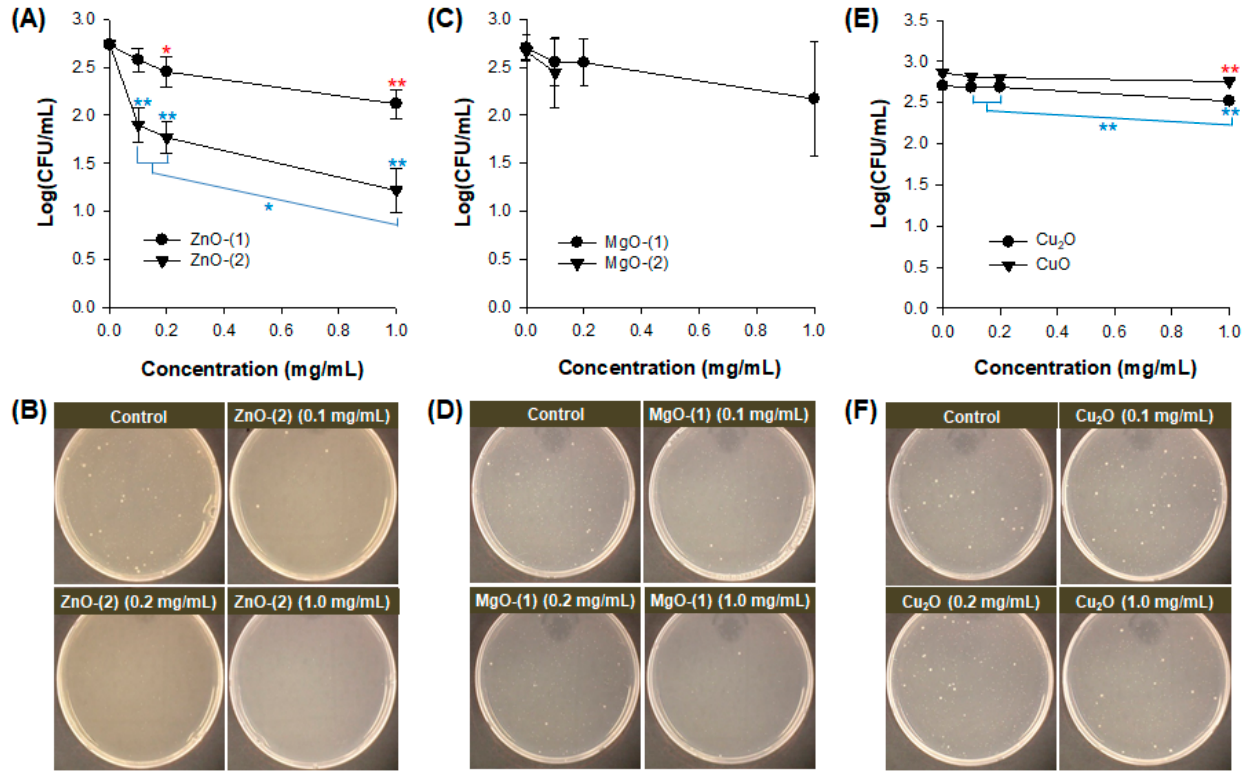
Figure 3. Antimicrobial effect of metal oxide (MO) particles against Escherichia coli : plots of concentration (mg/mL) versus log(CFU/mL) and representative plate images of ( A , B ) ZnO-(1), and ZnO-(2); ( C , D ) MgO-(1), and MgO-(2); ( E , F ) Cu 2 O, and CuO. *, p < 0.05; **, p < 0.01.